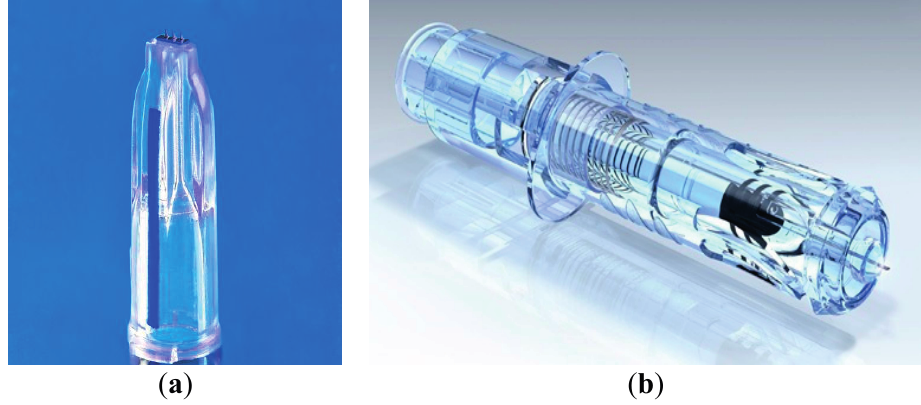
Figure 14. Current commercial MNs-based products ( a ) Intanza ® and ( b ) MicronJet ®